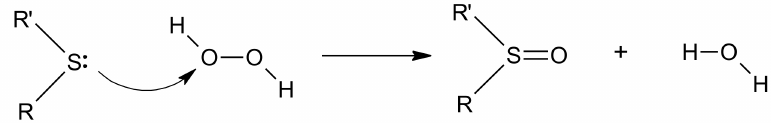
Scheme 1. Nucleophilic attack of the sulfur atom on the oxygen atom.